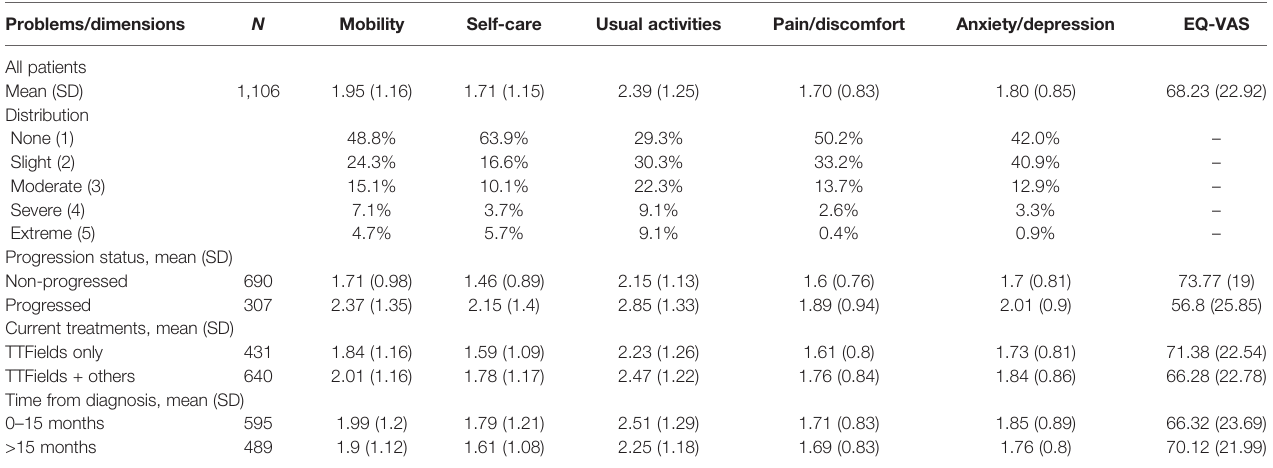
TABLE 2 | Overall distribution of levels in the EQ-5D-5L dimensions.